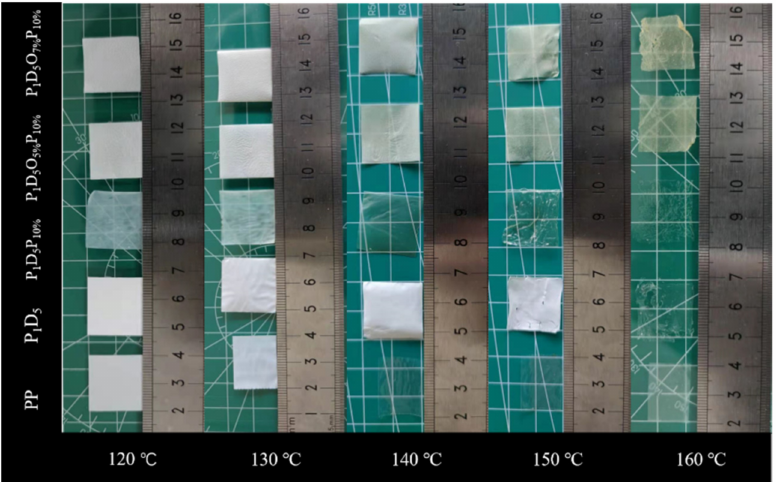
Figure 6. The thermal shrinkage pictures of each group of membranes at different temperatures.